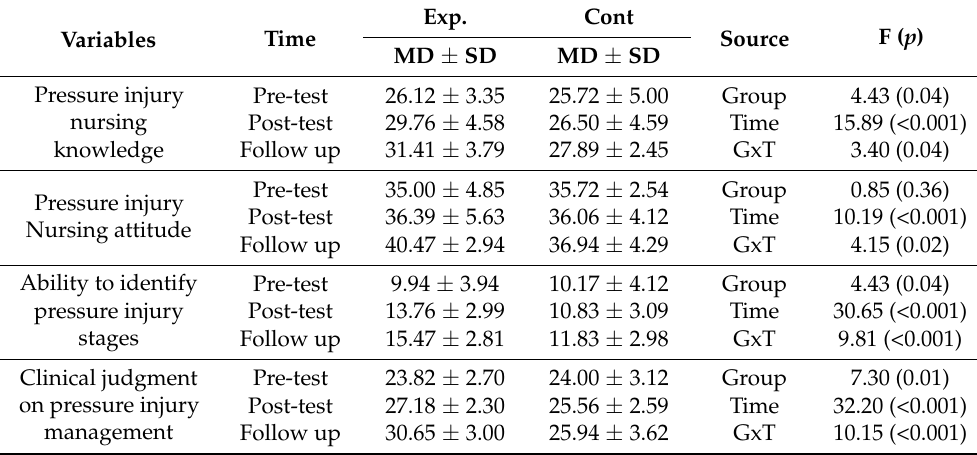
Table 3. Effectiveness of the educational